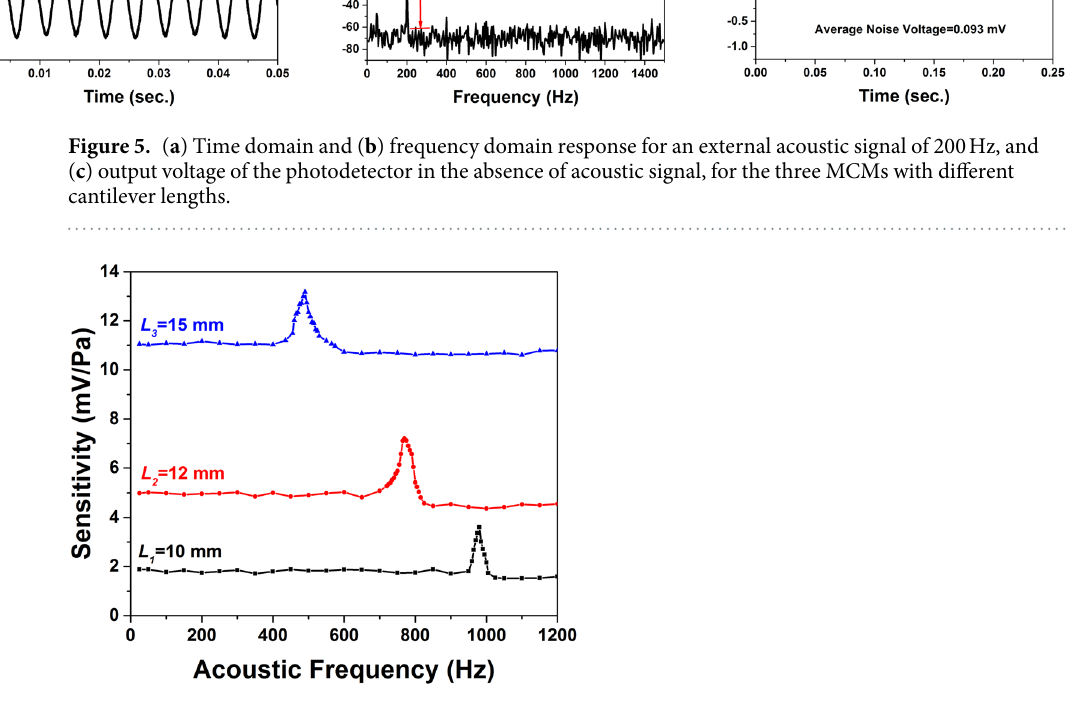
Figure 6. The variation of acoustic sensitivity with frequency for the three sensors with different cantilever